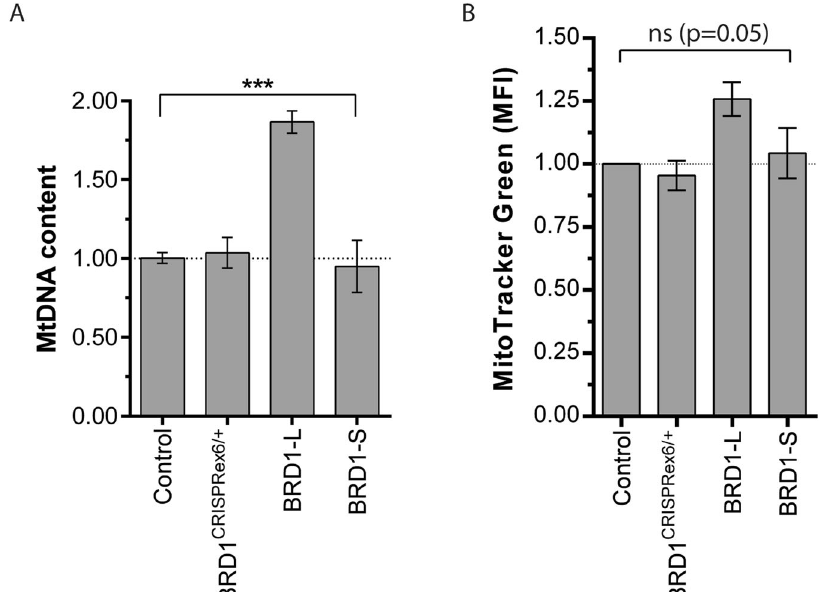
Fig. 4 Investigation of the effect of altered BRD1 expression on mitochondrial amount. A Mitochondrial DNA content relative to the mean of two nuclear reference genes ( GAPDH and SLC34A2 ) ( n = 3/group). b Mitochondrial mass ( n = 3/group). Control: naïve HEK293T cells, BRD1 CRISPRex6/ + : Clone #3 of BRD1 CRISPRex6/ + HEK293T cells, BRD1-L: HEK293T cells stably overexpressing the BRD1-L isoform, BRD1-S: HEK293T cells stably overexpressing the BRD1-S isoform. Data presented as mean ± SEM. P -value as determined using ANOVA (brackets). p < 0.001 (***); not signi fi cant